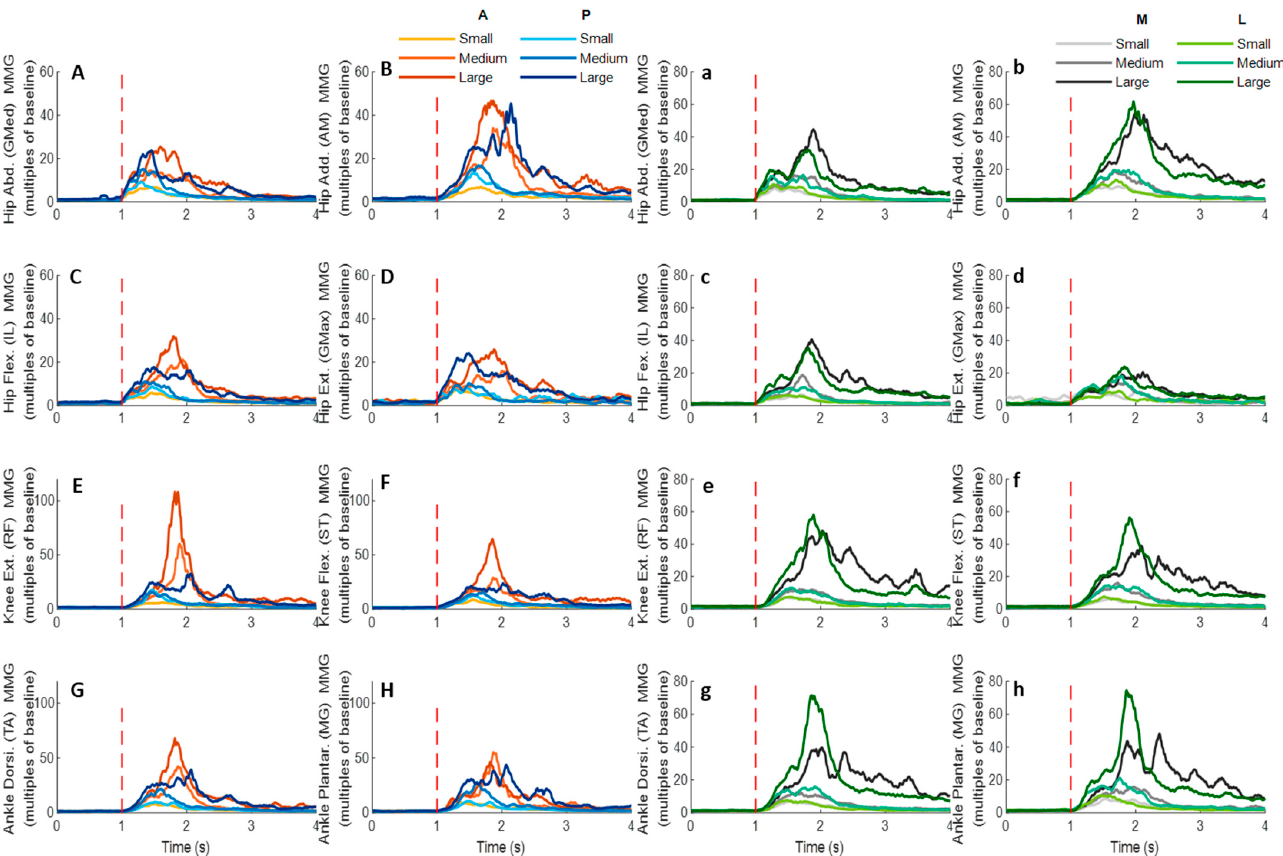
Figure 14. The mean MMG signal changes of twelve participants for eight dominant-leg muscles following the unexpected anterior, posterior, medial, and lateral perturbations with three magnitudes ( n = 12). Mean MMG signal changes for hip abductor-adductor ( A , B ), hip flexor-extensor ( C , D ), knee extensor-flexor ( E , F ), and ankle dorsiflexor-plantarflexor ( G , H ) following anterior and posterior perturbations; Mean MMG signal changes of hip abductor-adductor ( a , b ), hip flexor-extensor ( c , d ), knee extensor-flexor ( e , f ), and ankle dorsiflexor-plantarflexor ( g , h ) following medial and lateral perturbations. (Note: The MMG amplitude values were multiples of the 1000-ms baseline mean value before a pulling perturbation. The red dotted line indicated the start of pulling perturbation. MMG : mechanomyography. GMed : gluteus medius; AM : adductor magus; IL : iliopsoas; GMax : gluteus maximus; RF : rectus femoris; ST : semitendinosus; TA : tibialis anterior; MG : gastrocnemius medialis; A : anterior; P : posterior; M : medial; L : lateral).